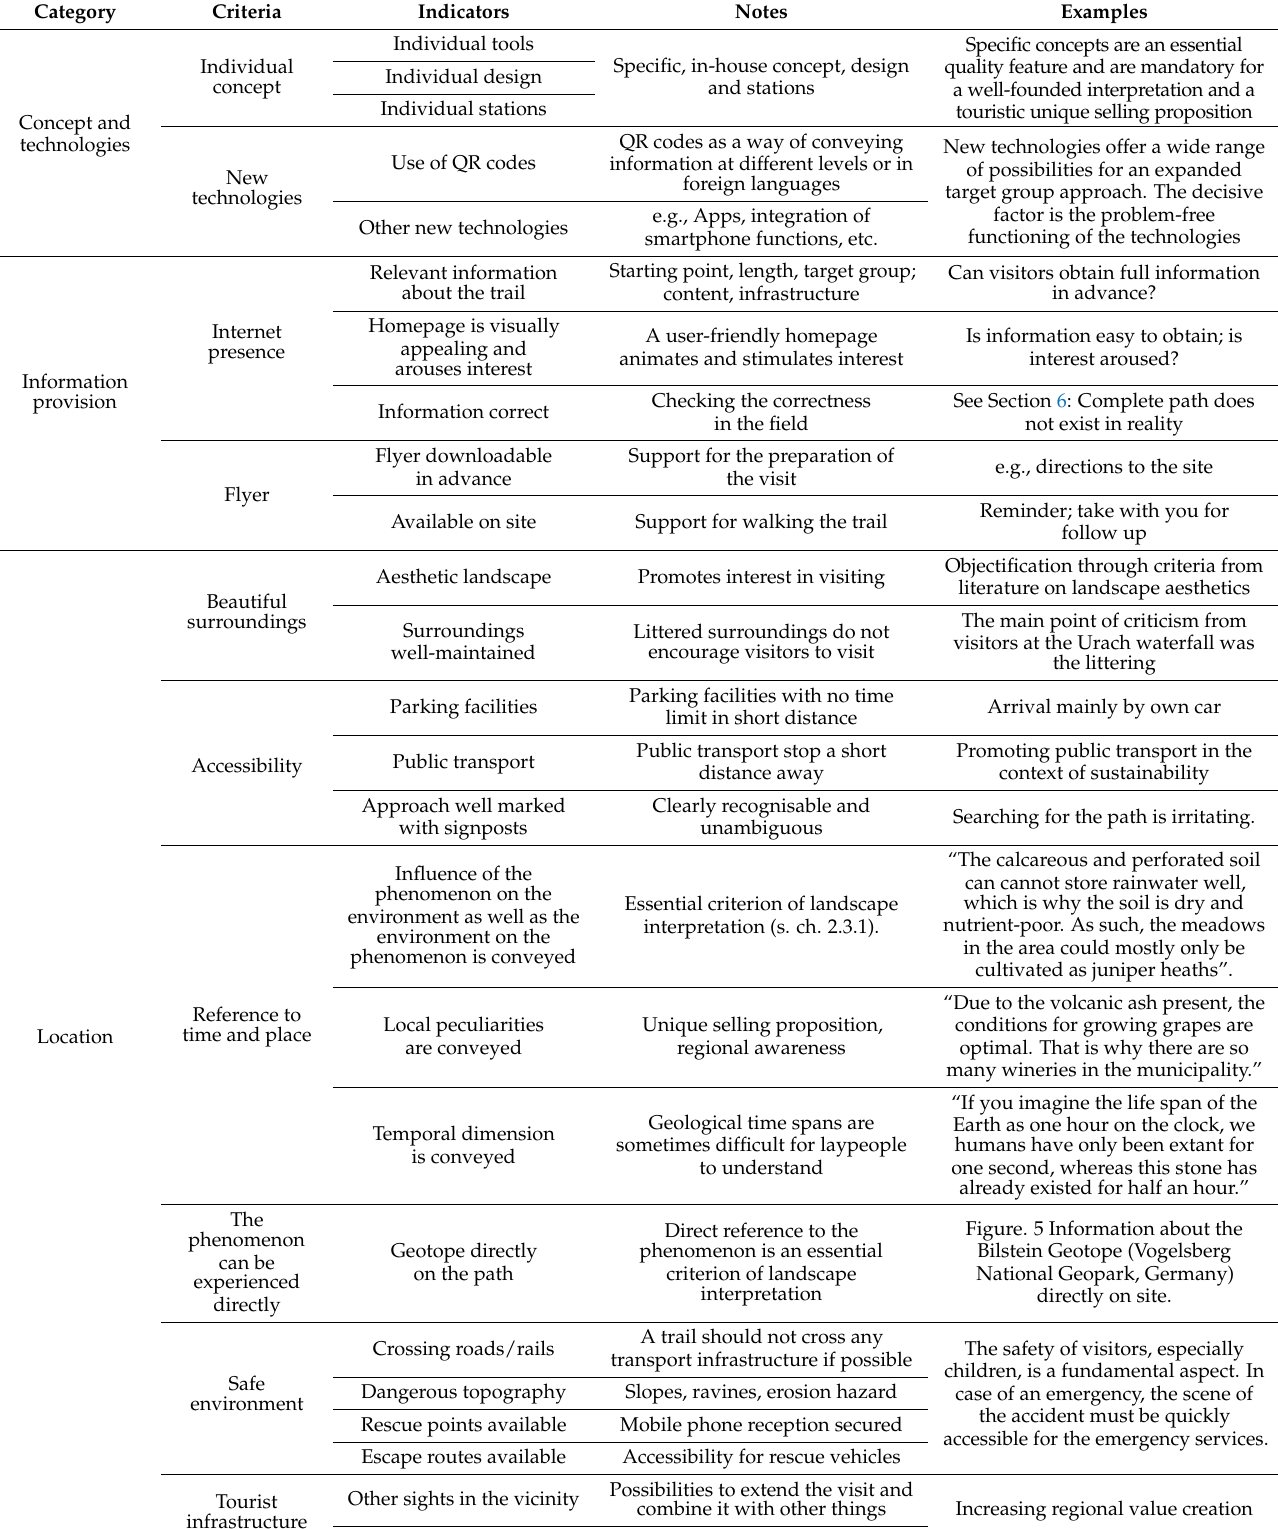
Table 1. Criteria for geotrail evaluation in UGGp Swabian Alb.